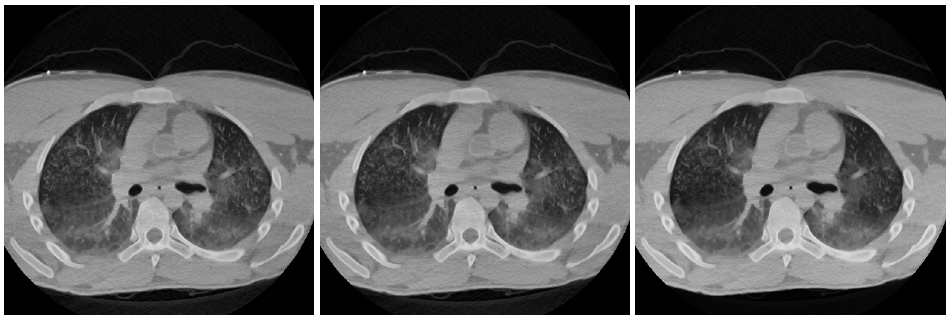
Figure 12. Calculating the histograms using spatial downsampling along each axis. Even significant downsampling does not cause very visible artefacts, which is also reflected in the TMQI score. However, local differences might appear, e.g., compare the middle region of the left lung in ( a ) and ( f